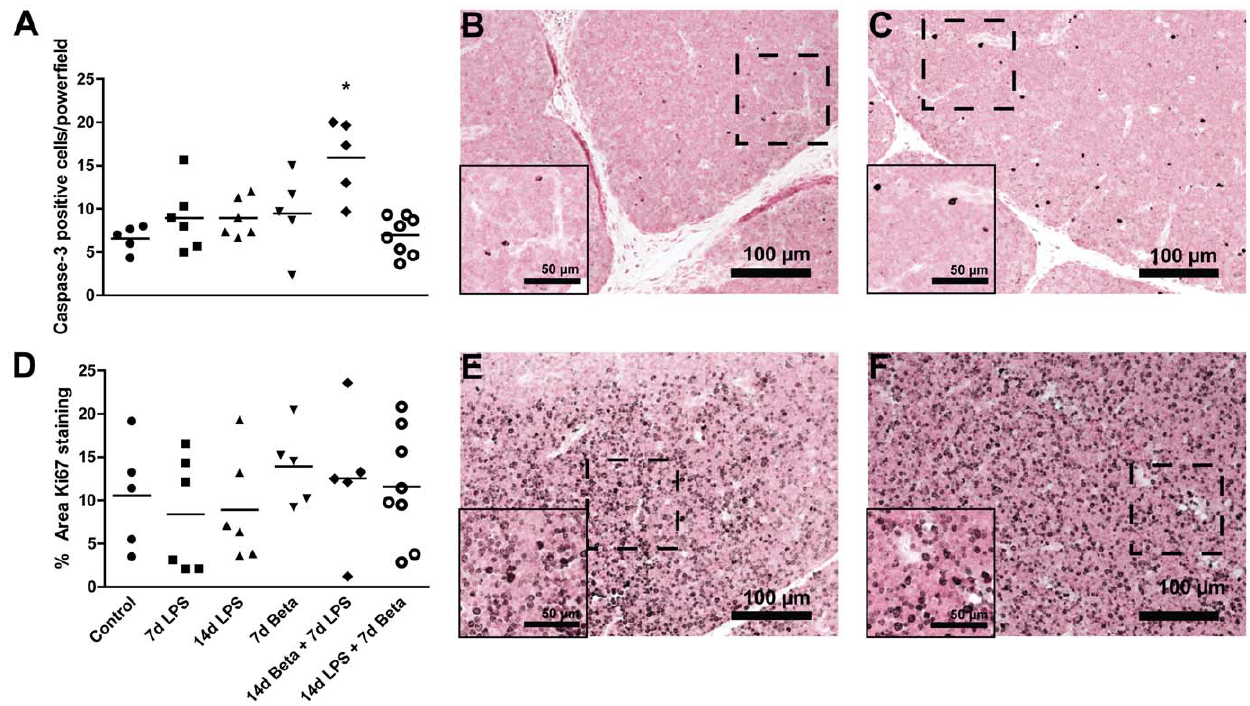
Figure 3. Cleaved caspase-3 and Ki67 expression. A: Cleaved caspase-3 positive cells increased in the thymus in the 14 d Beta + 7 d LPS group ( C ) when compared to controls ( B ). D: No changes in the percentage of Ki67-positive stained area were detected in any of the experimental groups compared to control. Representative images are shown for controls ( E ) and 7 d LPS animals ( F ). Magnification 200 6 ; magnification insert: 400 6 . * p , 0.05 versus controls.